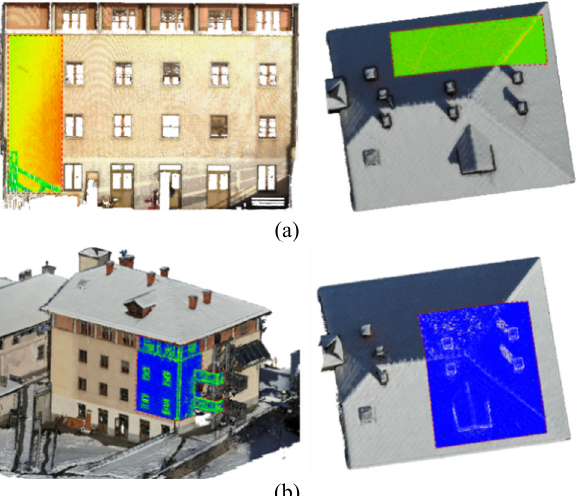
Figure 3. Selected areas on the façade (a) and the roof (b) for the density analysis.